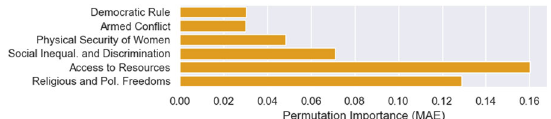
Fig. 3 The importance of the NMF components in the best performing model. Permutation importance (Altmann et al., 2010) was used.